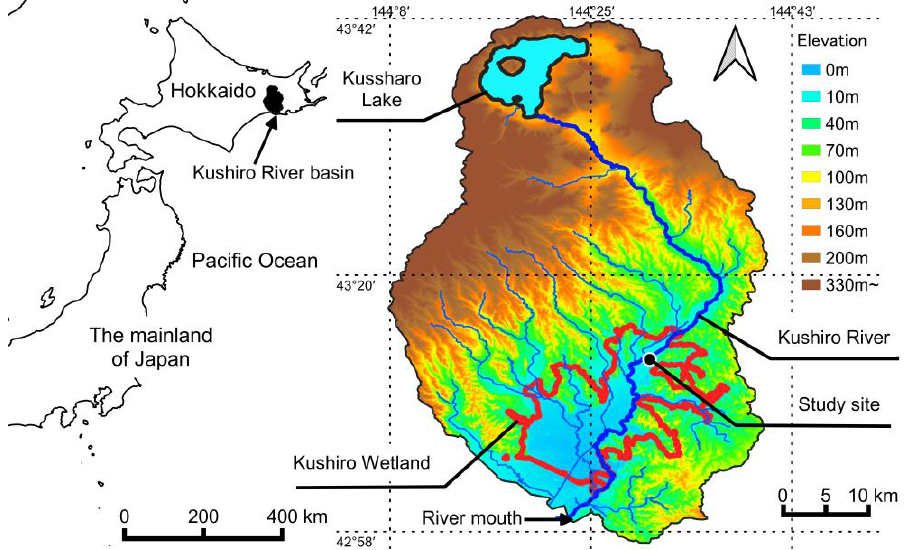
Figure 1. The Locations of the Kushiro River basin, Kushiro Wetland, and the study site area. Source: modified from the data in National Geodetic Data Download Service (administrative area, watershed/non-watershed boundary, natural park area, lake, and river) [54]. 1:10 m from Natural Earth by Physical Vectors Coastline.